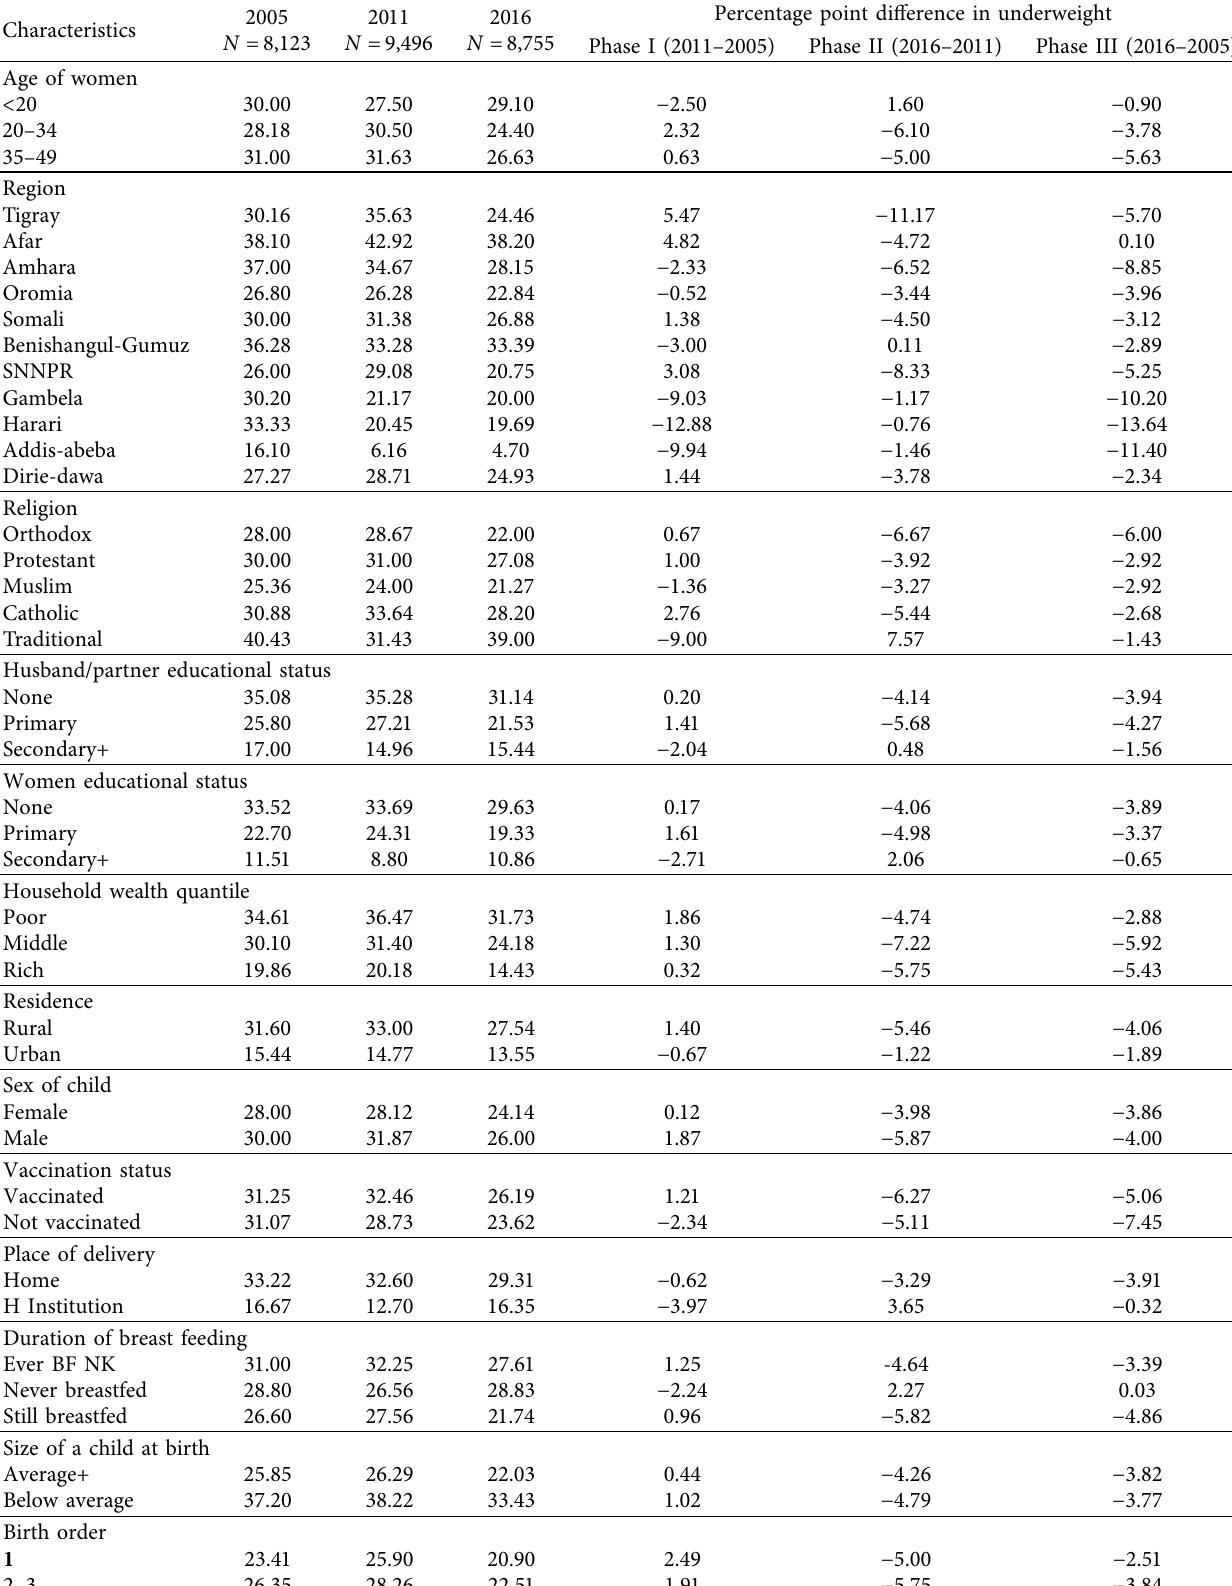
Table 3: Trends in underweight among children under five years from 2005, 2011, and 2016 EDHS.